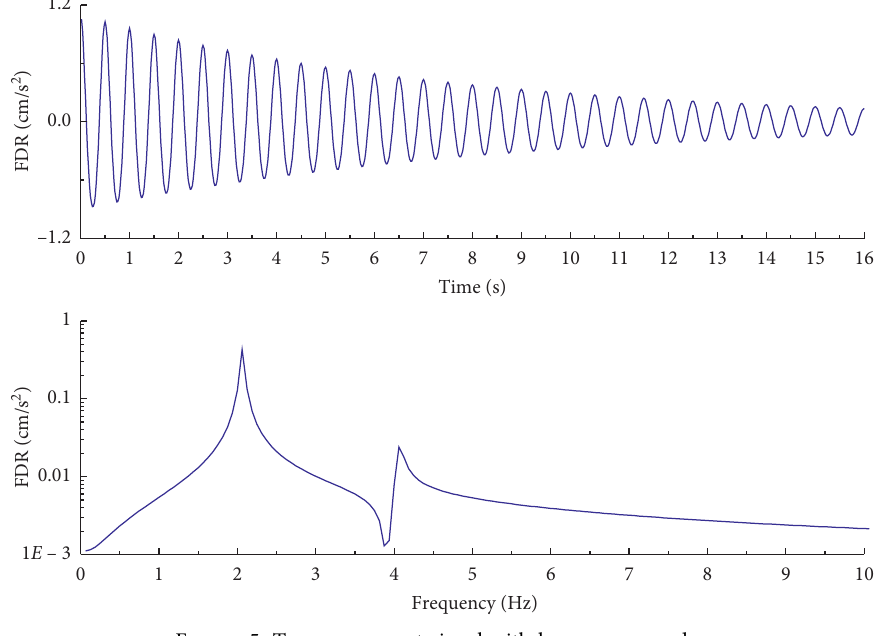
Figure 5: Two-component signal with low-energy mode.